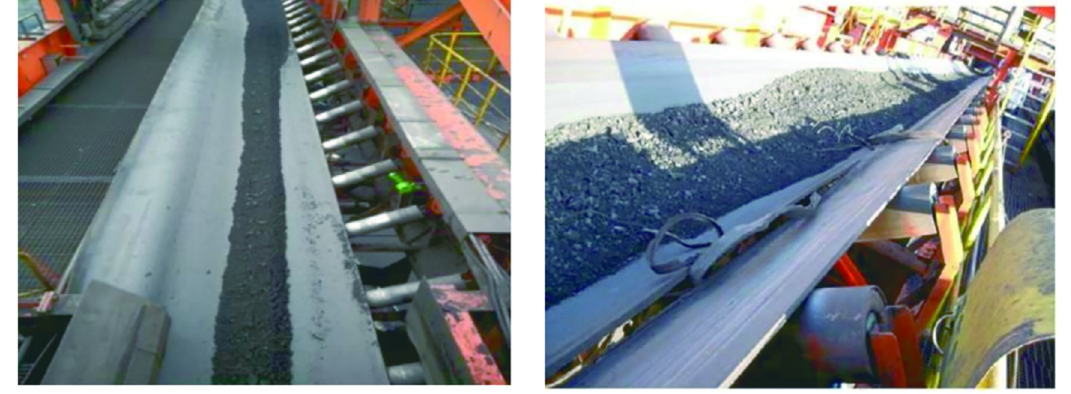
Fig 7. Conveyor failure